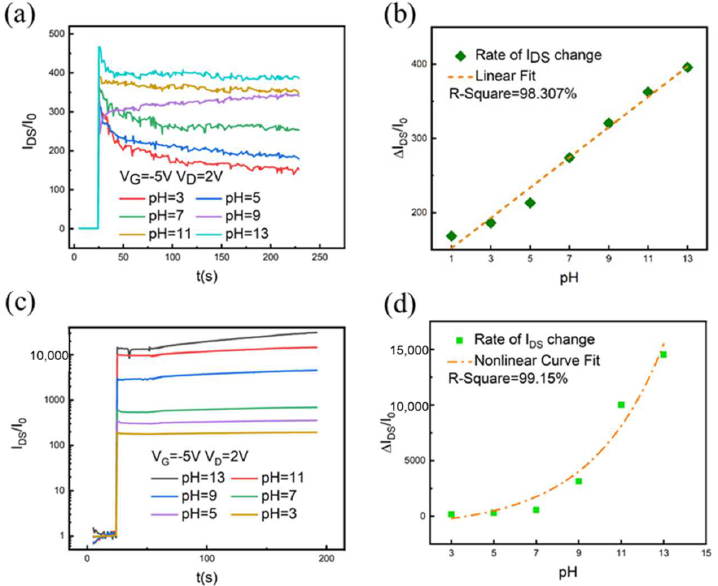
Figure 6. ( a ) Real-time response curve of I DS as a function of time for SiNW FET in different pH solutions, and ( b ) Current rate of change under different pH time-response curves of SiNW FETs. ( c ) Real-time response curve of I DS as a function of time for hydrogel-functionalized SiNW FET in different pH solutions, and ( d ) Current rate of change under different pH time-response curves of hydrogel-functionalized SiNW